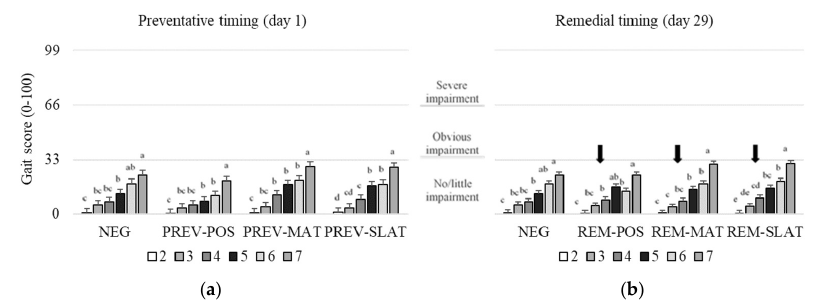
Figure 6. Mean gait scores (raw means ± SEM) of birds that received ( a ) preventative provision of the